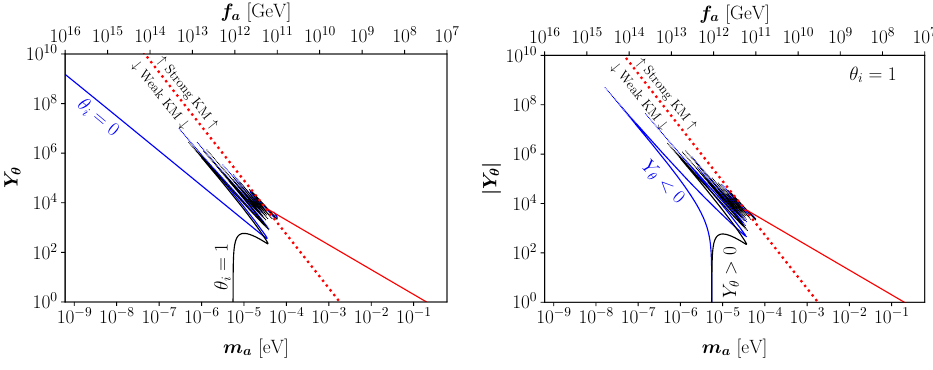
Figure 4. Weak kinetic misalignment. Left panel : Yield Y θ as a function of the DM axion mass m a , for the values of the initial misalignment angle θ i = 0 (blue) and θ i = 1 (black). Right panel : a function of the DM axion mass m a , assuming θ i = 1 and considering either Y θ > 0 (black) or Y θ < 0 (blue). In both panels, the red dotted line separates the regimes of weak (to left) and strong (to right)